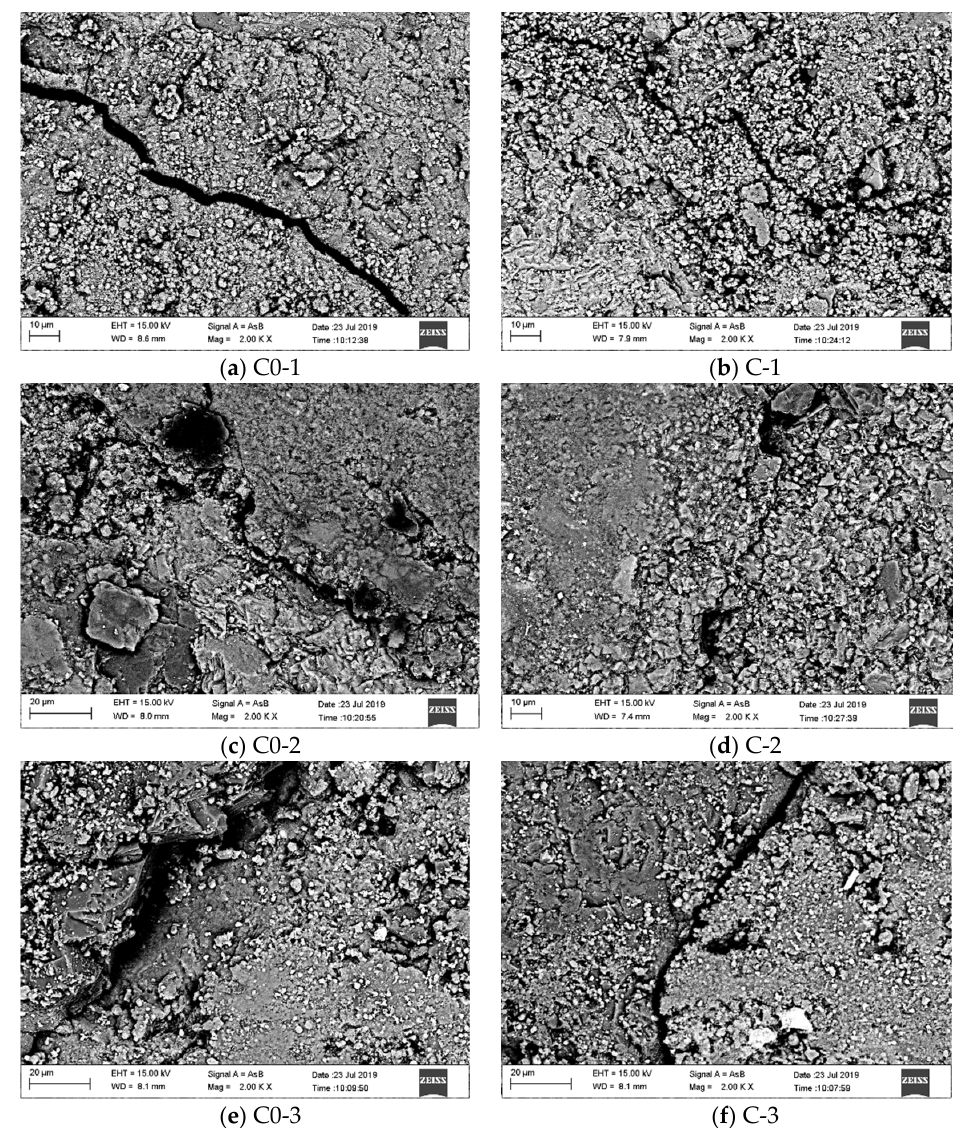
Figure 6. Micro-morphology of the interface transition zone in the concrete (×2000).